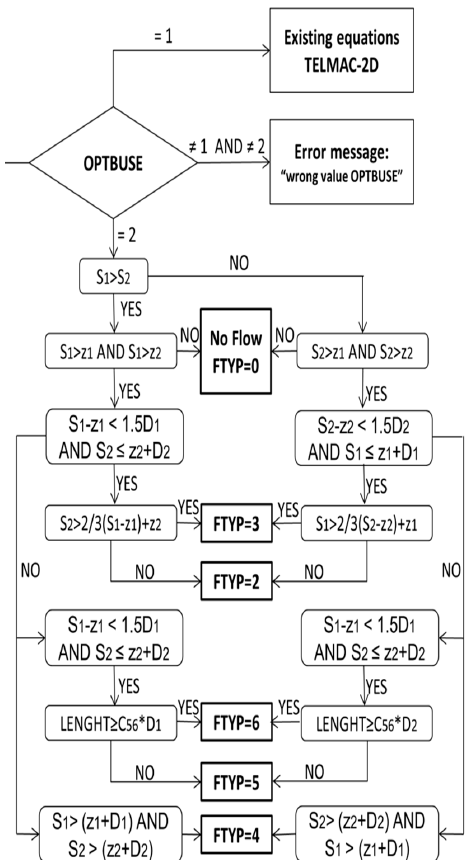
Figure A1. Flow chart showing the conditions for every type of flow in the buse.f subroutine.